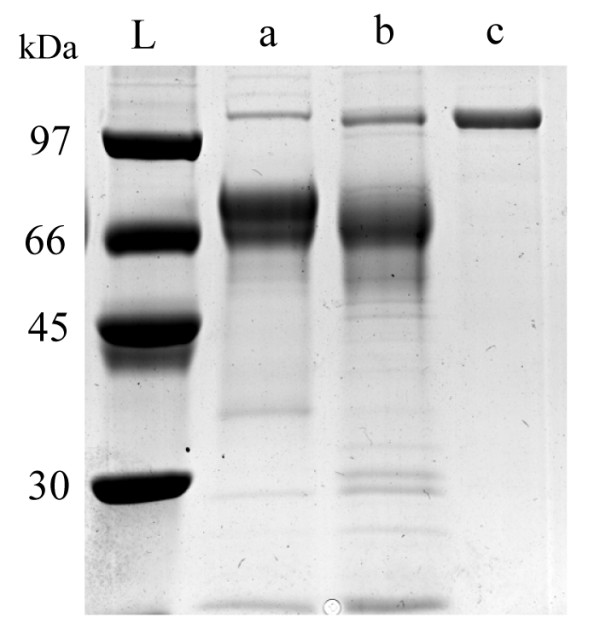
SDS-PAGE of extracellular proteins and purified TrLAC1. Total proteins from wild-type strain (lane a) and TrLAC1 transformant (lane b) were loaded onto an SDS-PAGE (11% polyacrylamide) gel. Gel was stained with Coomassie blue. L, molecular mass standards.